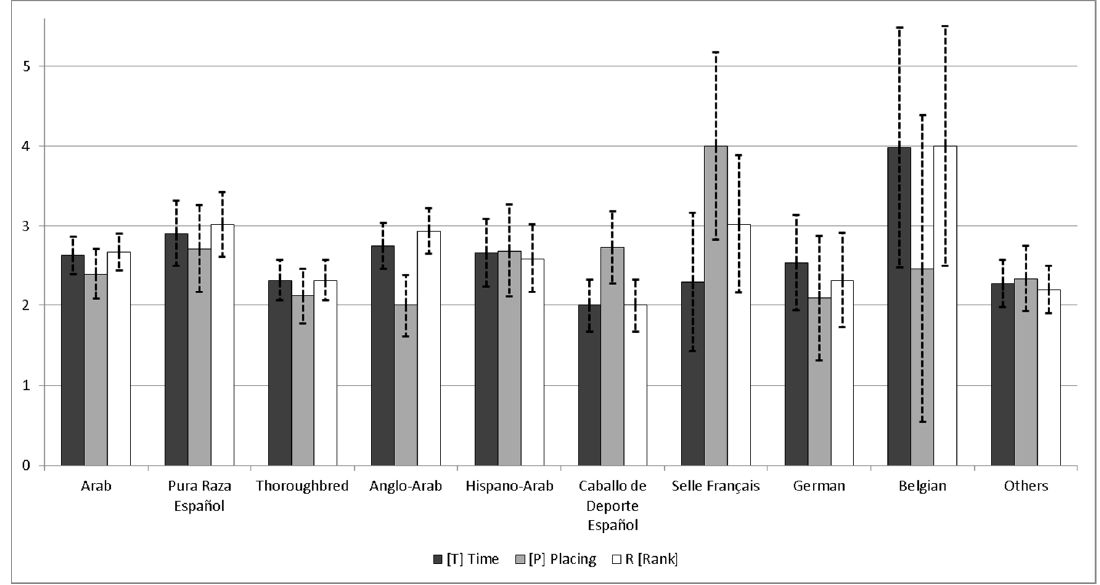
Figure 2. Means and standard deviations of the marginal posterior distributions for the genetic groups, transformed to positive scale, with the minimum fixed to 2.